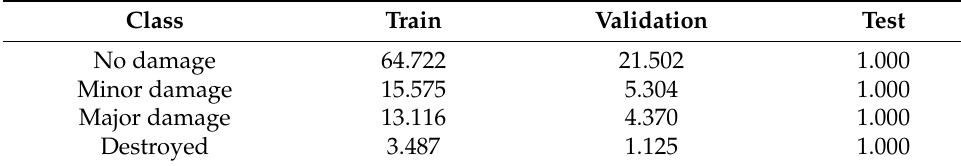
Table 3. Number of examples per class in train, validation and test